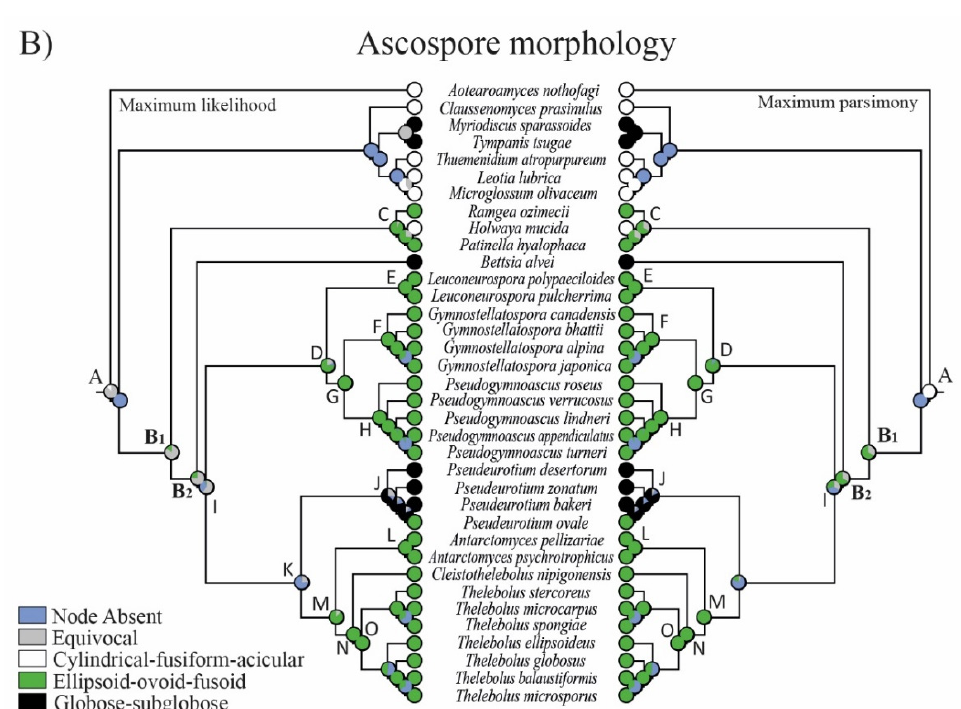
Figure 3. Evolution of ( A ) paraphyses and ( B ) ascospore morphology using parsimony and likelihood methods across 8000 BMCMC trees obtained from MrBayes. Pie charts at each node illustrate the likelihood (left) and parsimony (right) reconstruction and the proportion of the average received by each character state as the ancestral character of a given clade. Node absent indicates the proportion of nodes with posterior probabilities < 0.95 across trees. Equivocal indicates the same probability for the different features (not resolved).